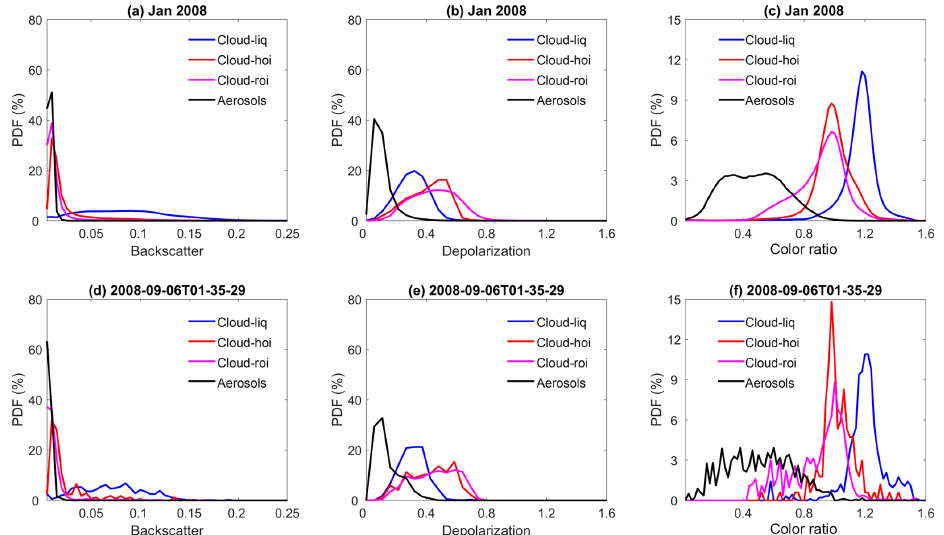
Figure 2. Comparisons of approximate probability density functions computed by normalizing the sum of the occurrence frequencies to 1; the top row (a–c) shows data from all of January 2008; bottom row (d–f) shows data from a single half orbit (6 September 2008, 01:35:29GMT). The left column (a, d) compares total attenuated backscatter PDFs; the center column (b, e) compares volume depolarization ratio PDFs; and the right column (c, f) compares total attenuated backscatter color ratio PDFs. Black lines represent aerosols, blue lines represent liquid water clouds, red lines represent ice clouds dominated by horizontal oriented ice (HOI), and magenta lines represent ice clouds dominated by random oriented ice